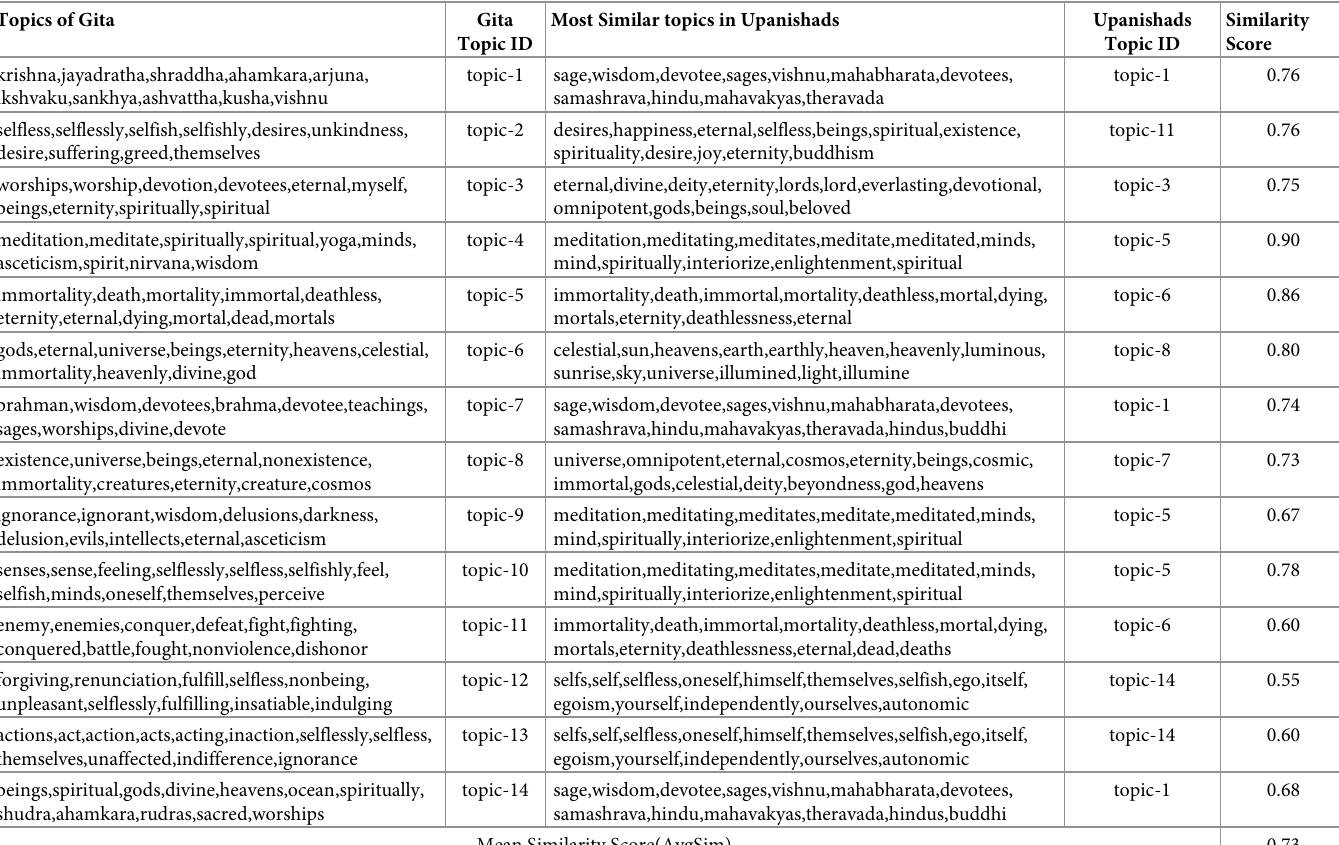
Table 5. Topics of the Bhagavad Gita(Eknath Easwaran) with most similar topics from the Upanishads(Eknath Easwaran). Topics of